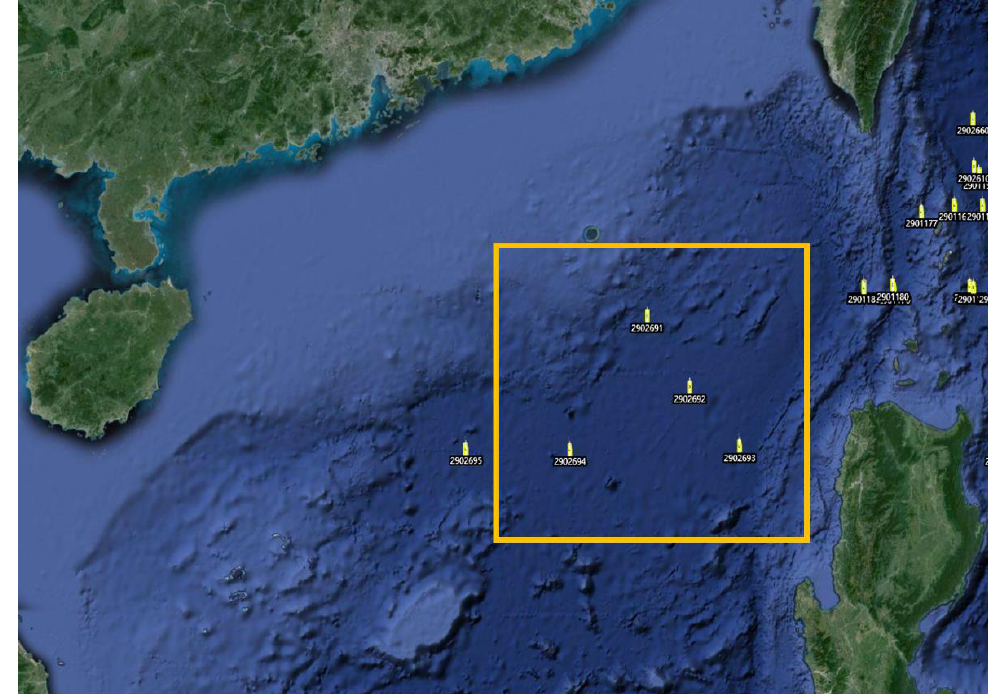
Figure 3. The position diagram of Argo buoys.